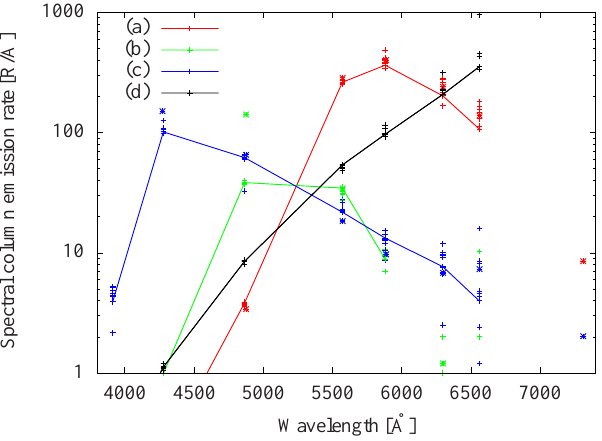
Fig.3. Intercalibrationresultsforthreesourcessince1981 (a) IRFUJOY275(SID5), (b) IRFUJOL1614(SID4), (c) IRFUJO920B(SID Fig. 3. Intercalibration results for three sources since 1981: (a) IRF 3), (d) IRFLauchelamp(SID101,since2000)The2011b-intercalibrationresultsareconnectedwithlinesgivingaroughideaofthespectra ofthesesources.The1981intercalibrationuseddifferentfiltersindicatedby“*”. UJO Y275 (SID 5), (b) IRF UJO L1614 (SID 4), (c) IRF UJO 920B (SID 3), (d) IRF Lauche lamp (SID 101, since 2000). The 2011b intercalibration results are connected with lines, giving a rough idea of the spectra of these sources. The 1981 intercalibration used dif- ferent filters indicated by a